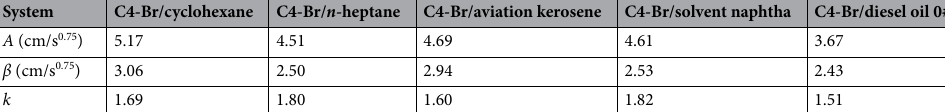
Table 1. The values of A , β and k in the different spreading systems at 25 °C.